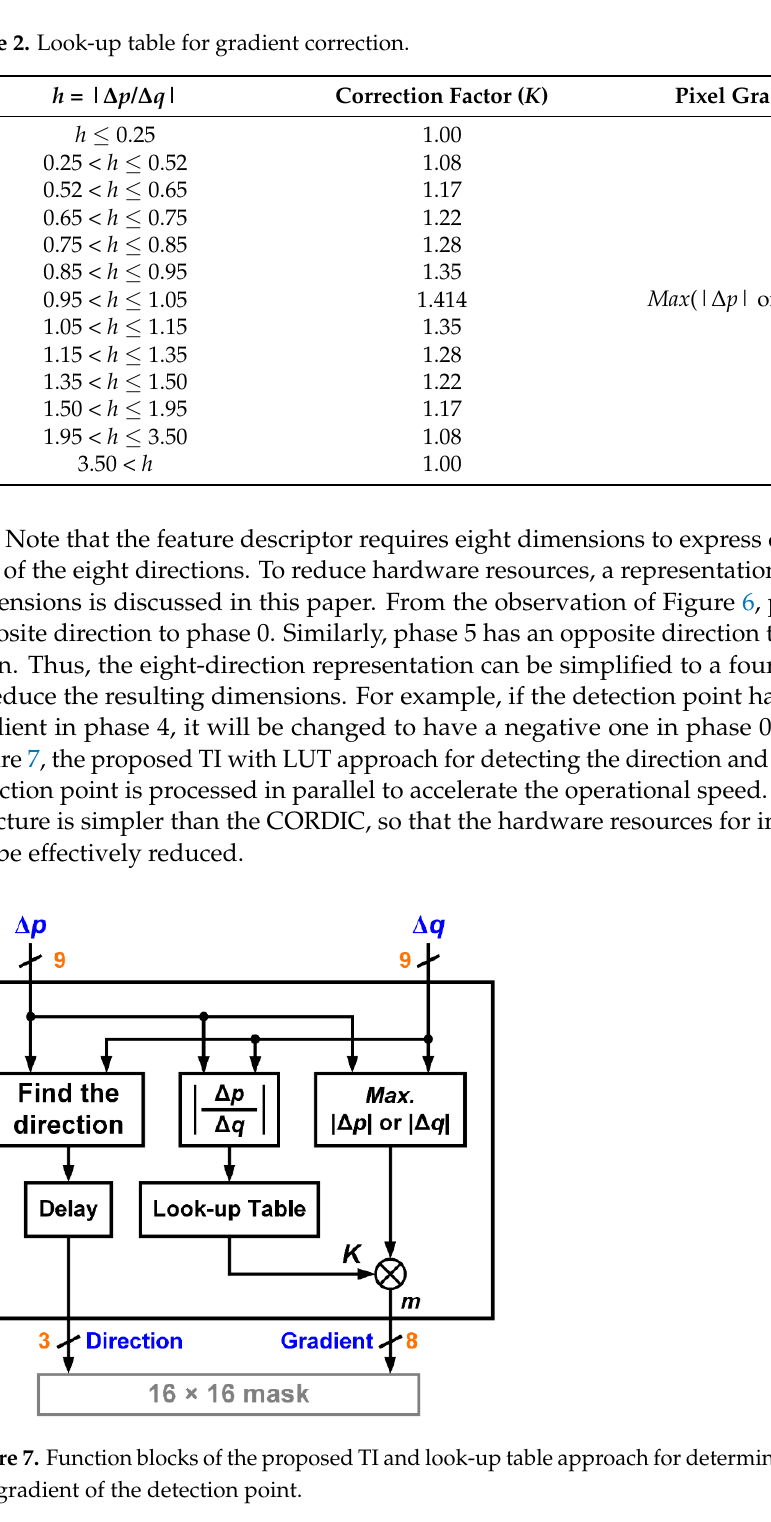
Table 2. Look-up table for gradient correction.